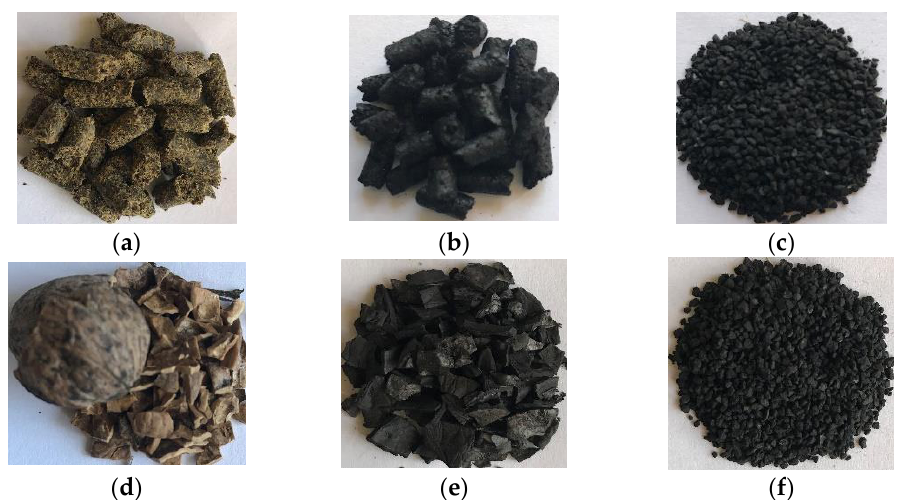
Figure 1. Raw biomass samples: ( a ) — rapeseed cake; and ( d ) — walnut shells; Biochars: ( b ) — rapeseed cake biochar (RSC); ( c ) — rapeseed cake biochar (RSC) with particles size ≤ 1 mm; ( e ) — walnut shell biochar (WSC); ( f ) —walnut shell biochar (WSC) with particle size ≤ 1 mm. The elemental compositions of RSC and WSC are presented in Table 1. The carbon content of raw biomass (RC and WS) were 45.91% and 47.67%, respectively.